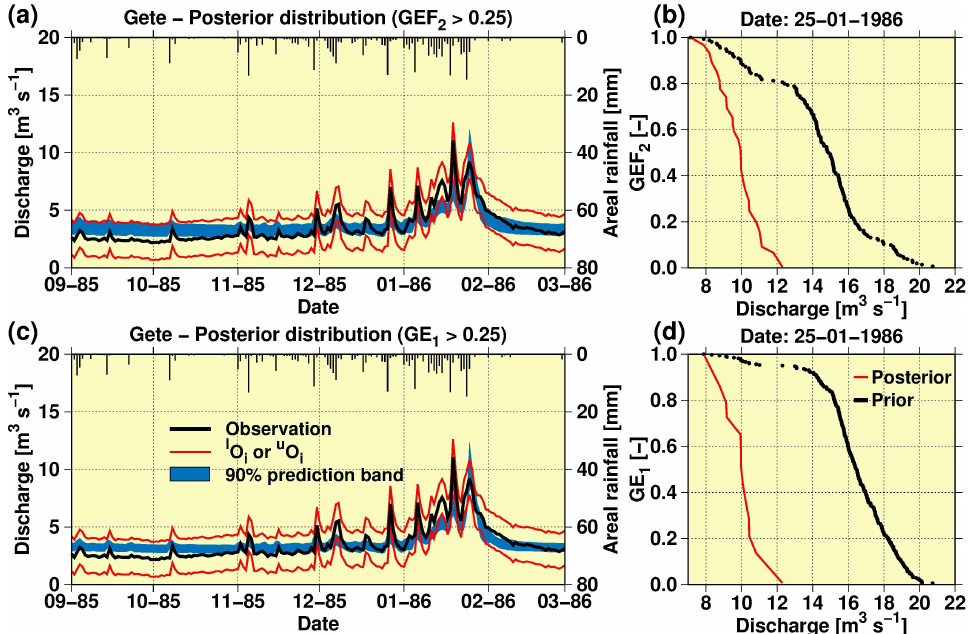
Figure 8. Ninety percent streamflow prediction limits for the Gete gauging station (posterior like- lihood distribution), in the validation period [1 September 1985–1 March 1986], after conditioning based on observed stream flow at the three study gauging stations (i.e., the multi-site test) and the H-Q data uncertainty; and respective likelihood cumulative prior and posterior distributions on 25 January 1986, ( a , b ) using the EF 2 likelihood measure and ( c , d ) the E 1 likelihood